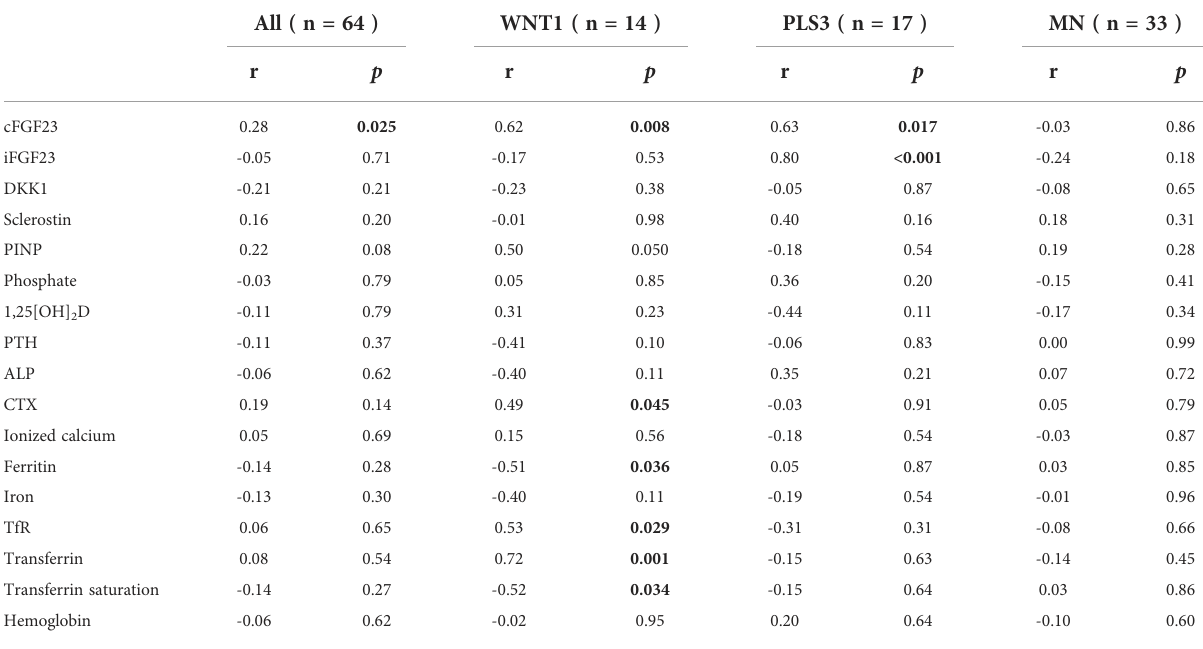
TABLE 3 Correlations between lipocalin-2 and other biomarkers of bone metabolism and iron status in WNT1 and PLS3 mutation-positive subjects, and MN family controls.